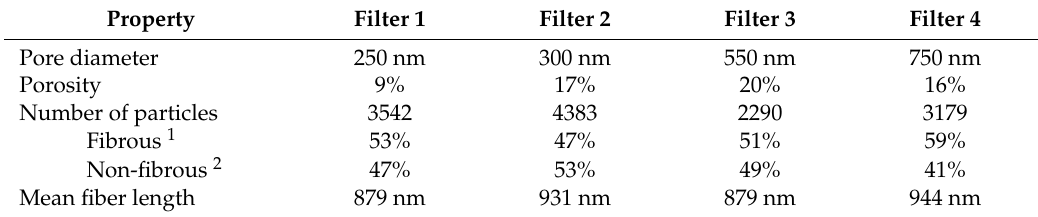
Table 12. Comparison of track-etched filters with different pore diameters and porosities. A test aerosol was generated by means of vibro-fluidization [33] and collected on the different filters. A total area of 0.054 mm² of each filter of 25 mm diameter was evaluated at random filter positions.